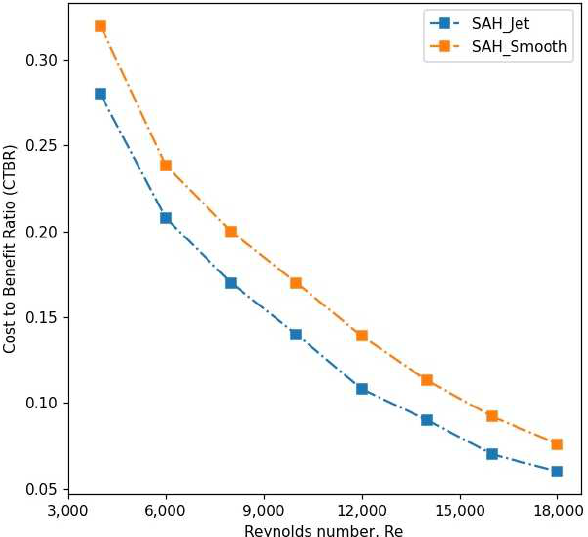
Figure 19. Improvement potential ( (cid:5)(cid:4) ) variation for ( a ) X/D h , (b) Y/D h and (c) d j /D h .